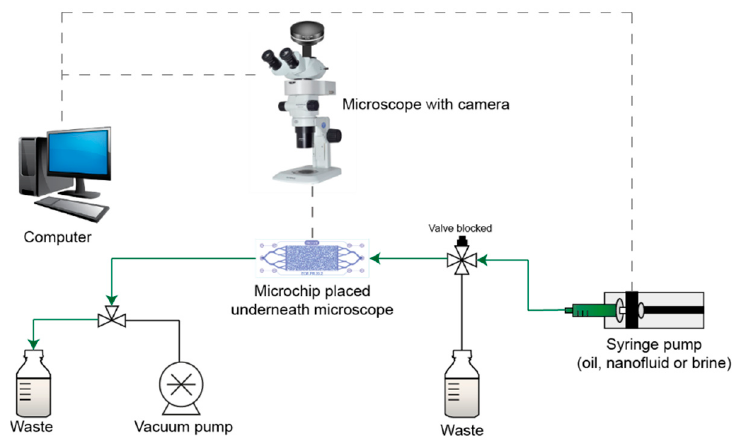
Figure 3. Schematic illustration of the experimental setup of the microfluidic experiment.